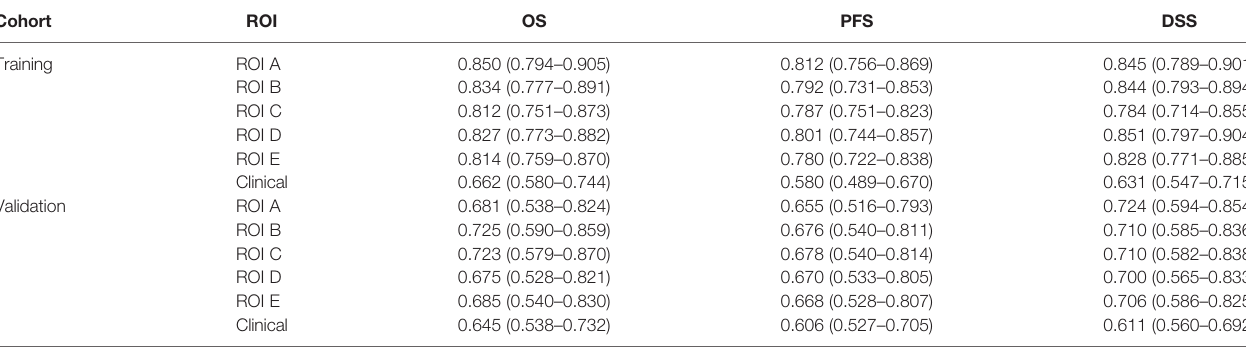
TABLE 2 | The Cox C-index of radiomics signature and clinical factors used for different clinical endpoints of glioblastoma patients in the training cohort and validation cohort.